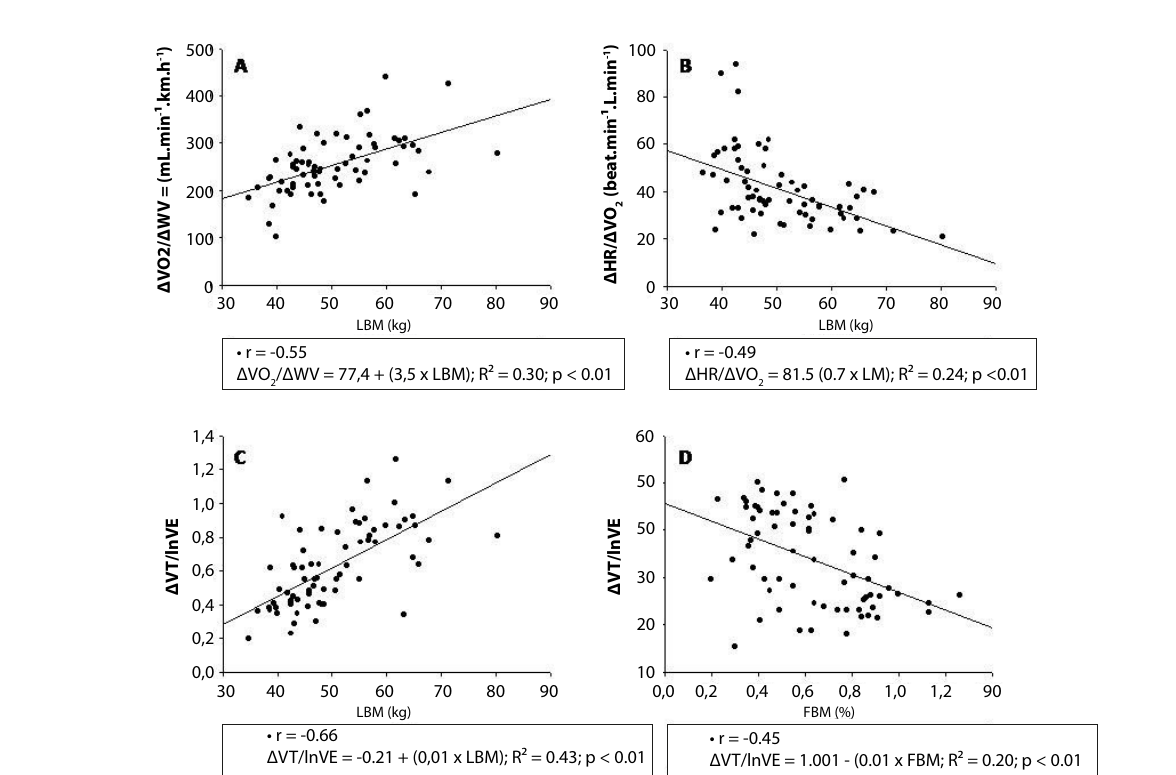
Figure 1 - Significant correlations among fat (FBM) and lean (LBM) body masses, and mechanical efficiency (ΔVO2/ΔWV), cardiovascular efficiency (ΔHR/ΔVO2) and breathing pattern